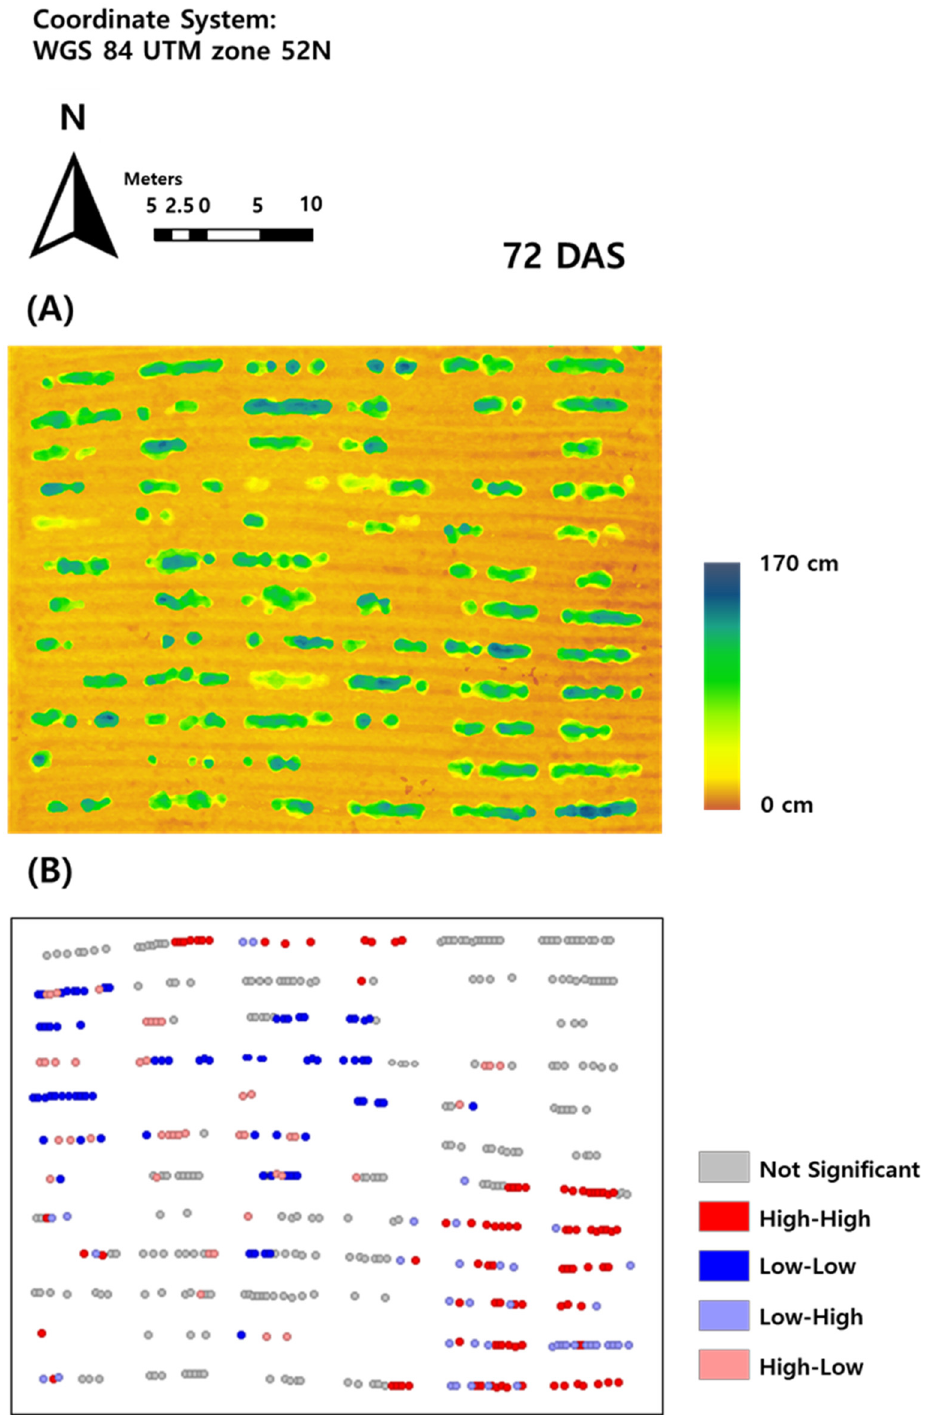
Figure 3. The result of the crop growth variable survey: plant height map ( A ), and LISA map applied with spatial autocorrelation analysis ( B ). In ( A ), the height of kenaf is represented by a color scale. Moreover, the spatial class identified through LISA analysis with the cut-off set to p -value < 0.01 was plotted on the LISA map as dots marked with five colors.